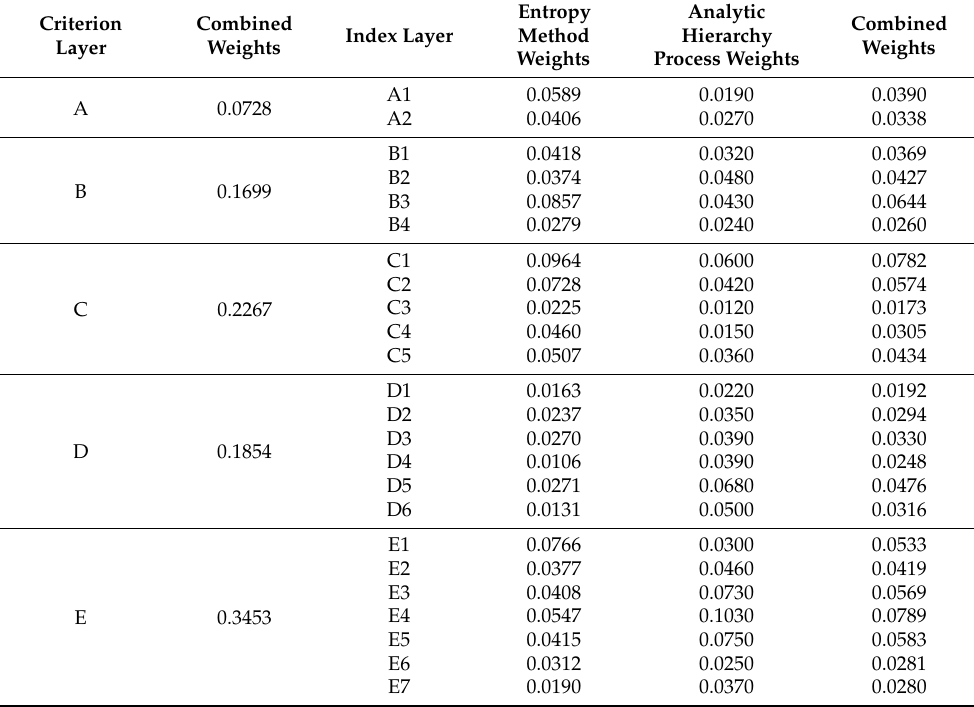
Table 3. Weights of the evaluation index system of grassroots water services in Hunan Province.